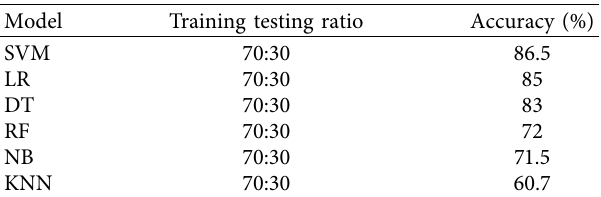
Table 2: Comparative analysis of ML models.